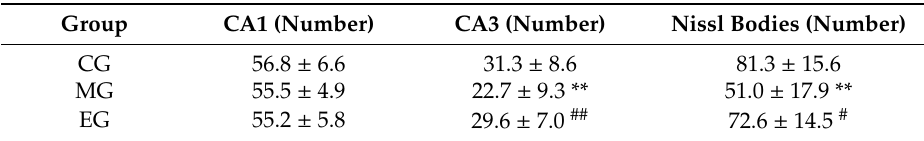
Figure 3. The Nissl staining results of the hippocampus in each group of mice under high magnification ( × 200). The first picture represents the CA3 of the control group of mice. The second represents model mice. The third represents the exercise mice. In the picture, red represents Nissl pyknosis, green for restored Nissl. Table 2. Effects of aerobic exercise on the number of pyramidal cells and intact Nissl bodies in the hippocampal CA1 and CA3 regions of depressed mice ( n = 6).